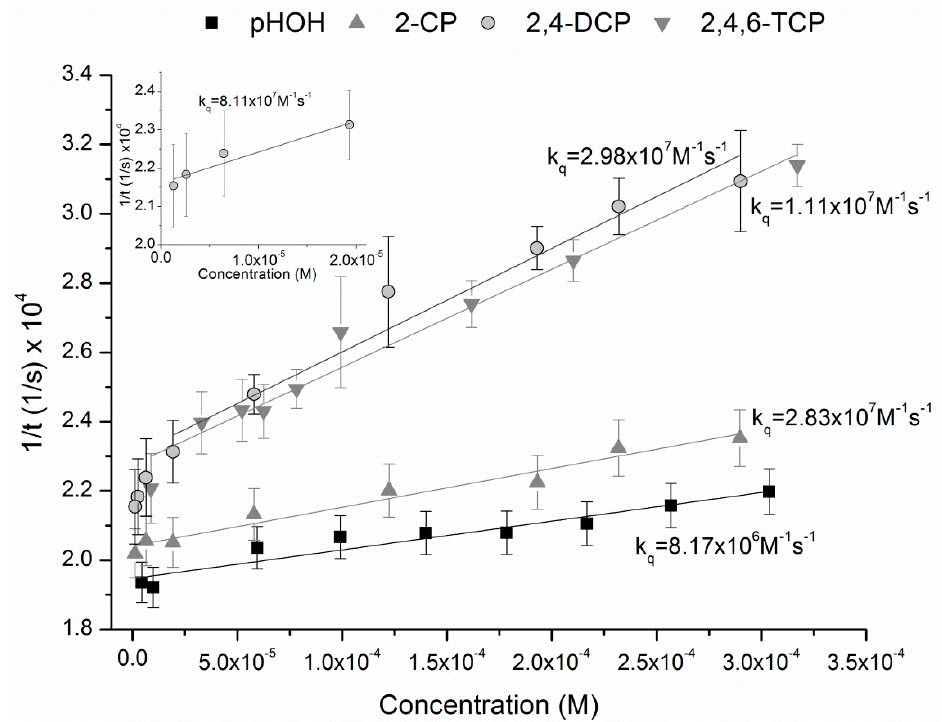
Figure 2. Determined values of the quenching rate constant of 1 O 2 for phenol and chlorophenols in acetone solution. Table 1. Determined rate constants of singlet oxygen quenching by pH-OH, 2-CP, 2,4-DCP, and 2,4,6-TCP in acetone solution.